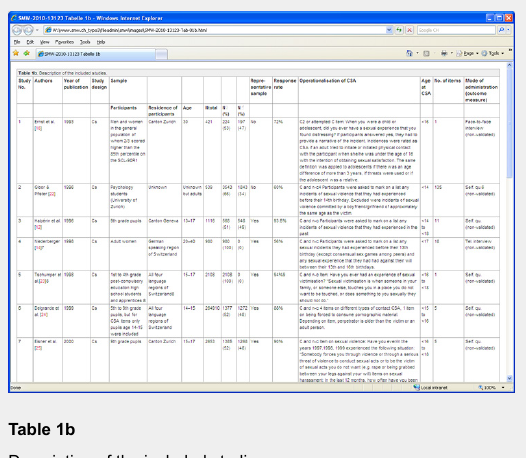
Description of the included